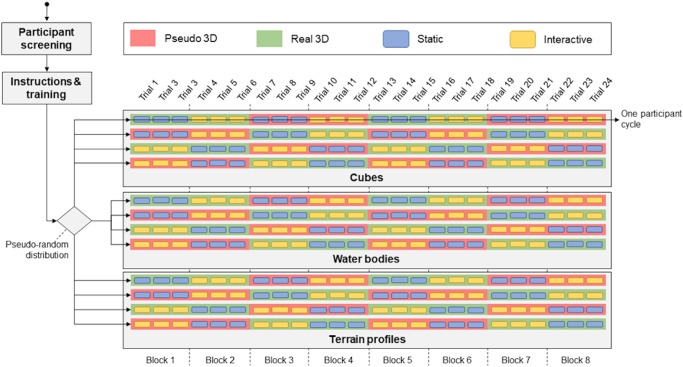
Diagram of the procedure of the experiment.